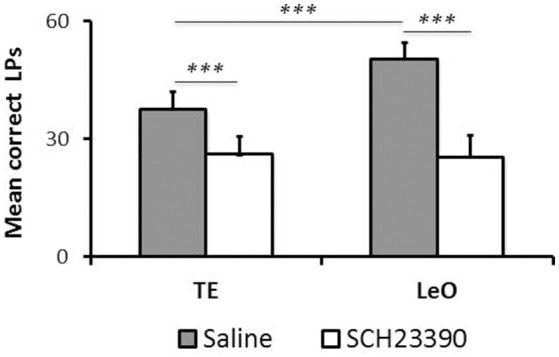
Long-term effect of SCH23390. The graph represents the mean numbers of correct lever presses (LPs) performed by each group after the learning criterion was reached (number of sessions = 6). ***
P < 0.001.